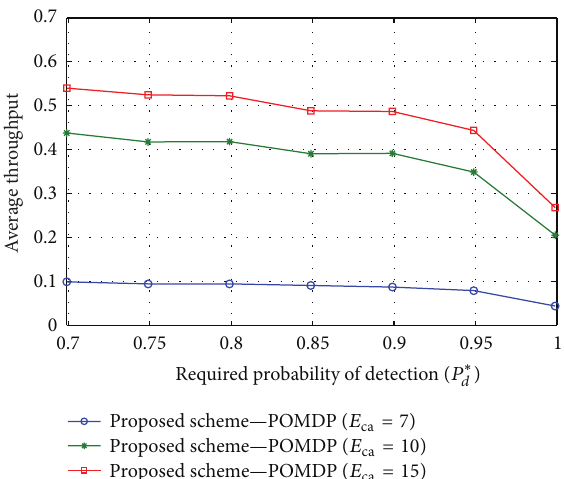
Figure 6: Average throughput versus the required detection proba- bility 𝑃 ∗ 𝑑 when 𝑒 𝑡